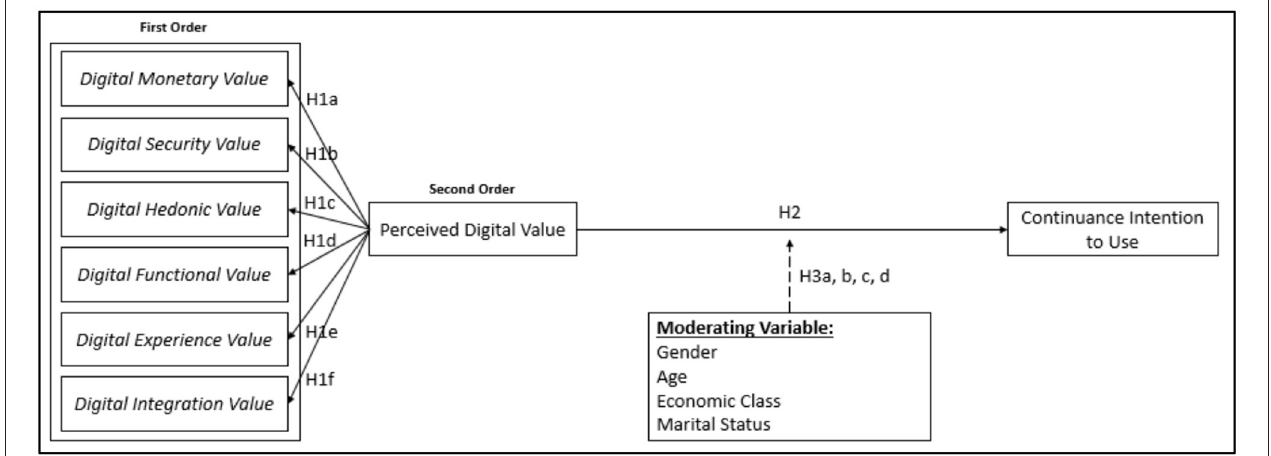
FIGURE 1 | Conceptual